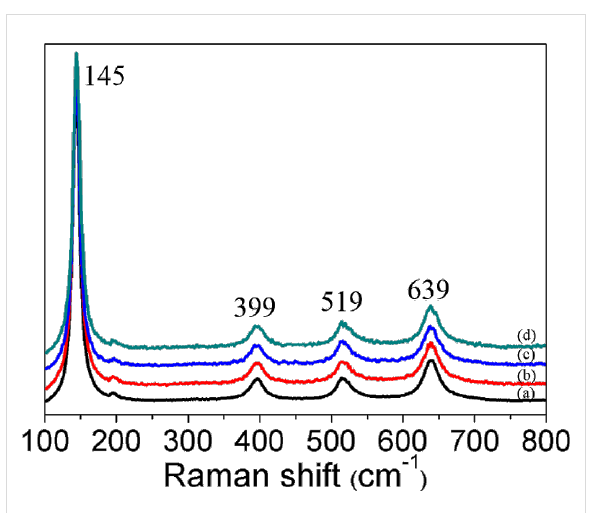
Figure 4: Raman spectra of a) TiO 2 , b) 0.5 wt % Pd/TiO 2 , c) 1.0 wt % Pd/TiO 2 and d) 3.0 wt % Pd/TiO 2